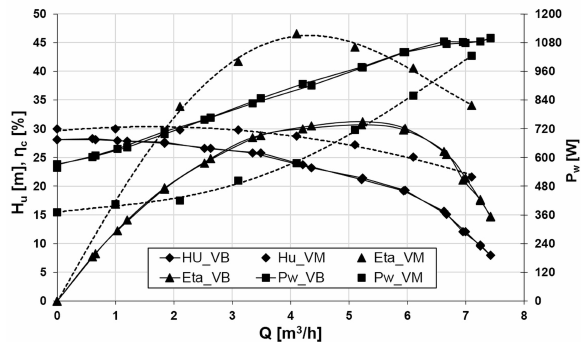
Figure 12: Characteristics of the pump with a hole impeller and two types of annular casing – VB and VM